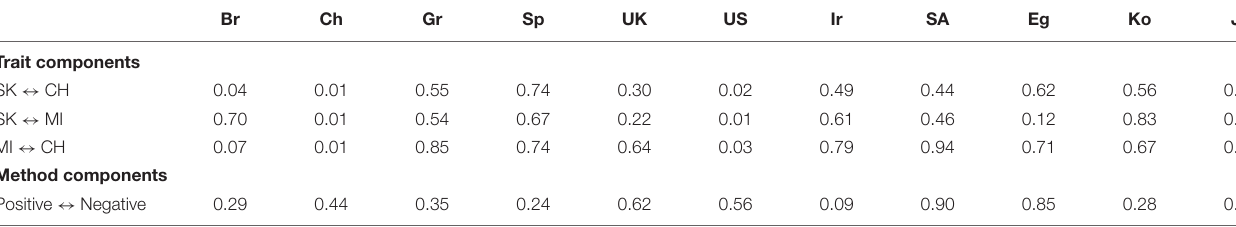
TABLE 5 | Common variance among trait and between method SCS components. Br